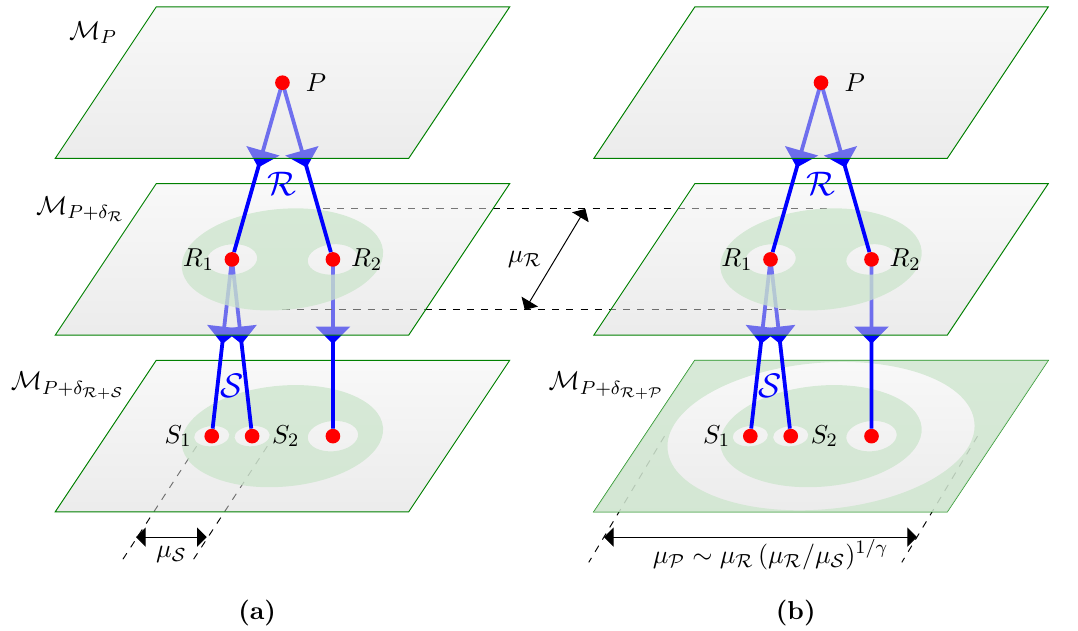
Figure 3 . (a) is a relevant operator at P . (b) S , at P P